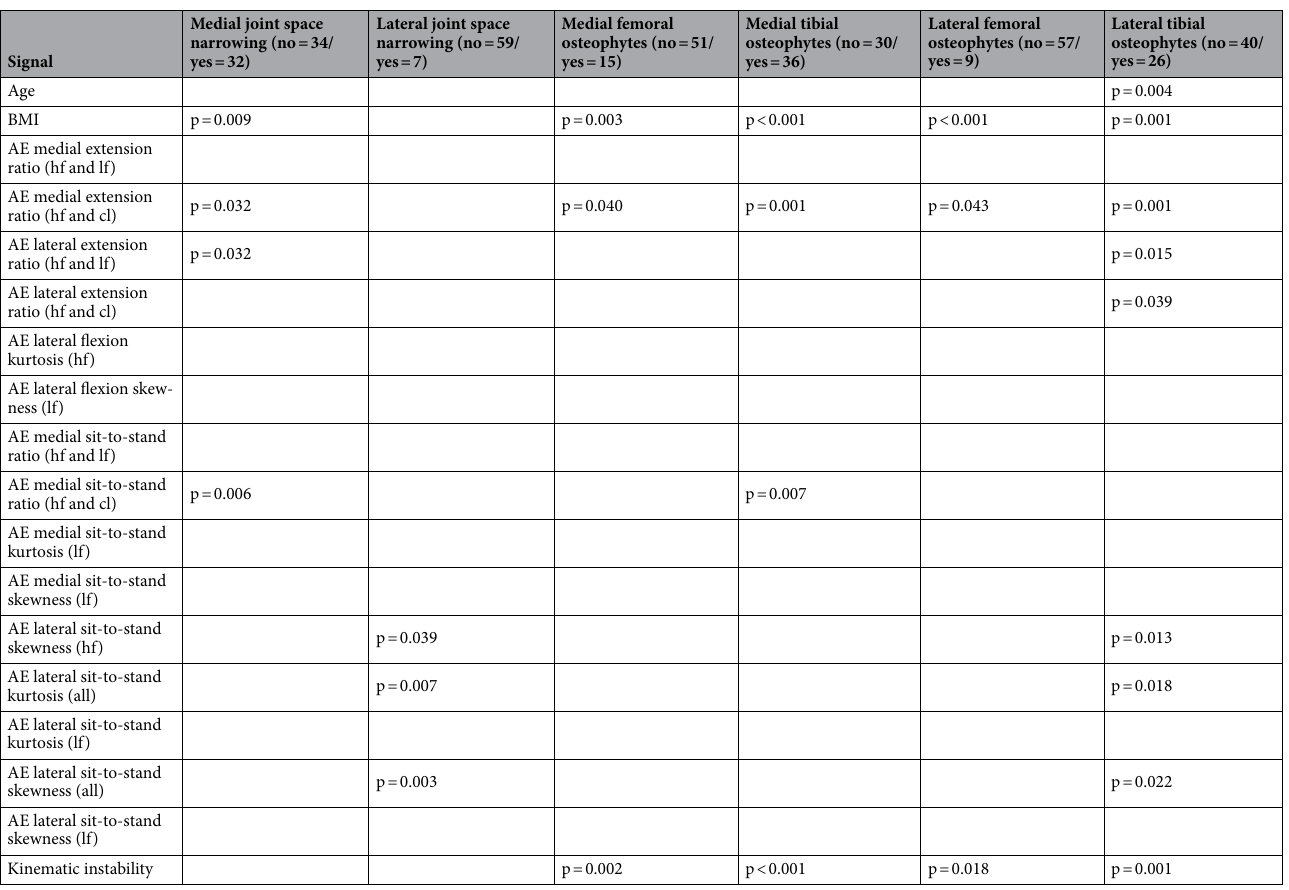
Table 3. The ability of acoustic emissions and kinematic instability (AUC > 0.600) to detect specific osteoarthritic changes in females. The absence or presence of osteoarthritic changes on conventional radiography are given in parentheses (no/yes), and corresponding statistically significant p-values for each biomarker. AE acoustic emission, BMI body mass index, hf high frequency, lf low frequency, cl clicks, all high and low